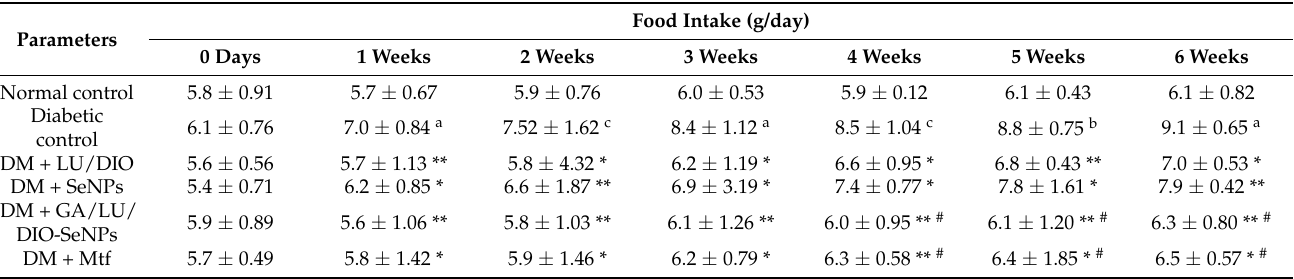
Table 3. Effect of flavonoid formulation (LU/DIO), SeNPs, and GA/LU/DIO-SeNPs on food intake, in diabetic